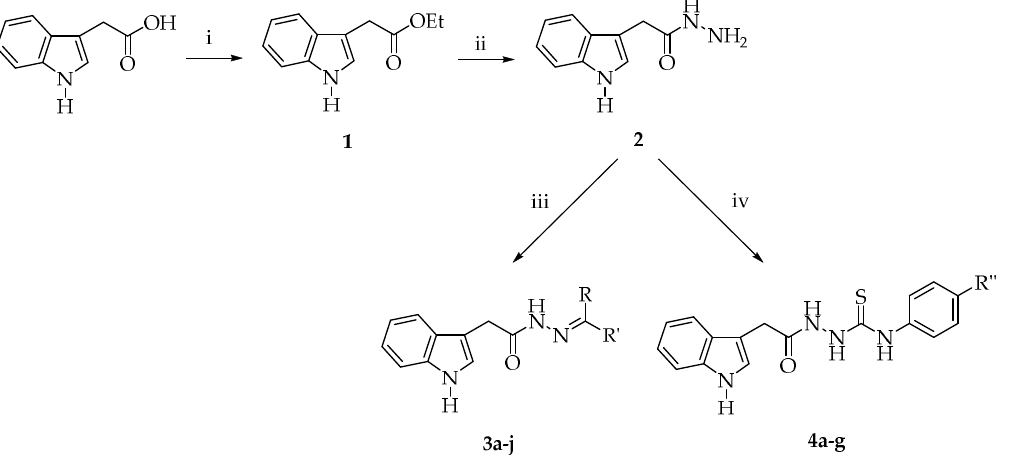
Figure 3. The synthetic route for the preparation of compounds 3a-j and 4a-g . Reagents and condi- tions: (i) EtOH, H 2 SO 4 , reflux, 12 h; (ii) NH 2 NH 2 .H 2 O, EtOH, reflux, 4 h; (iii) RCHO or RCOR′, EtOH, reflux, 15 h; (iv) R″C 6 H 4 NCS, EtOH, rt, 8 h.